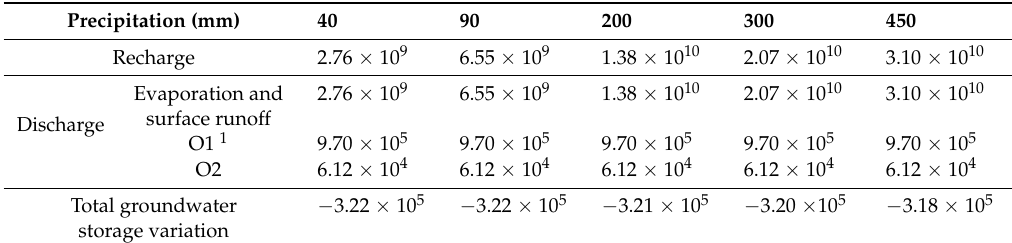
Table 3. The variation of groundwater budgets in five scenarios (m 3